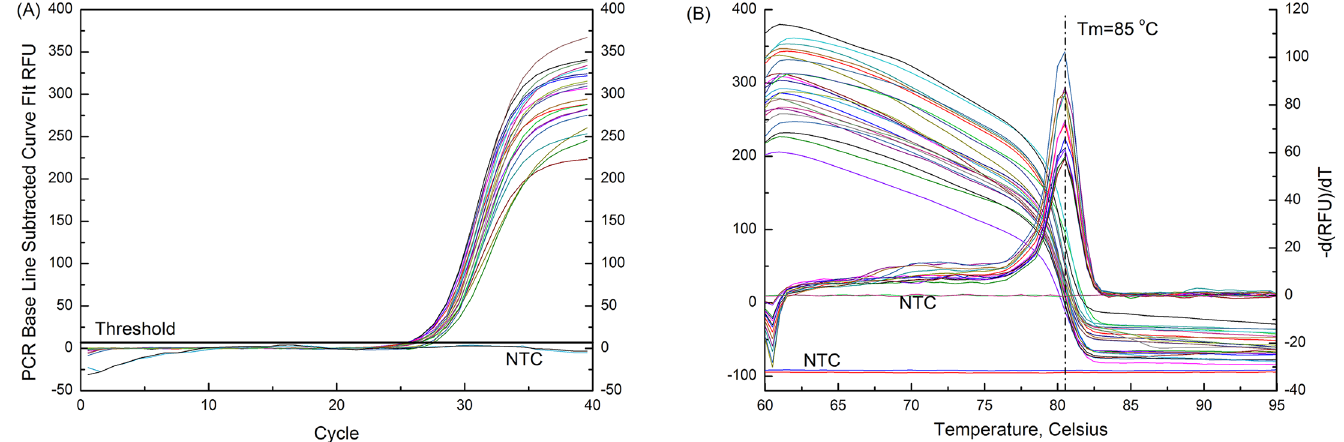
Fig 1. Detection of Alicyclobacillus spp. by the proposed real-time PCR assay with the 16S rDNA primer. (A) The representative real-time PCR amplification curves of various Alicyclobacillus spp. strains; (B) The melting curve analysis for Alicyclobacillus spp. amplicons.